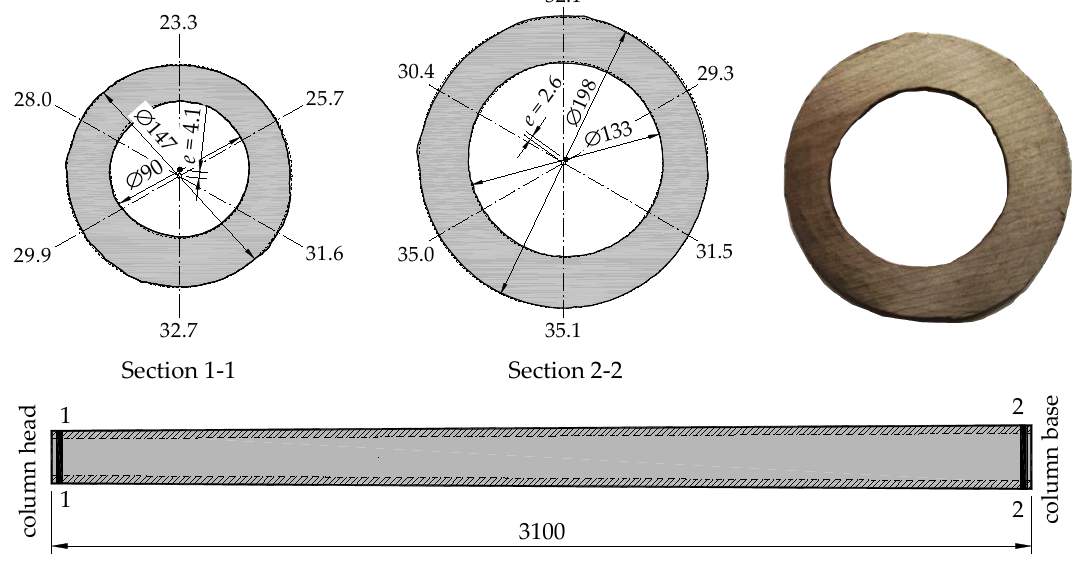
ff erent locations on the column Figure 2. Cross-sections at different locations on the column length. Figure 2. Cross-sections at di